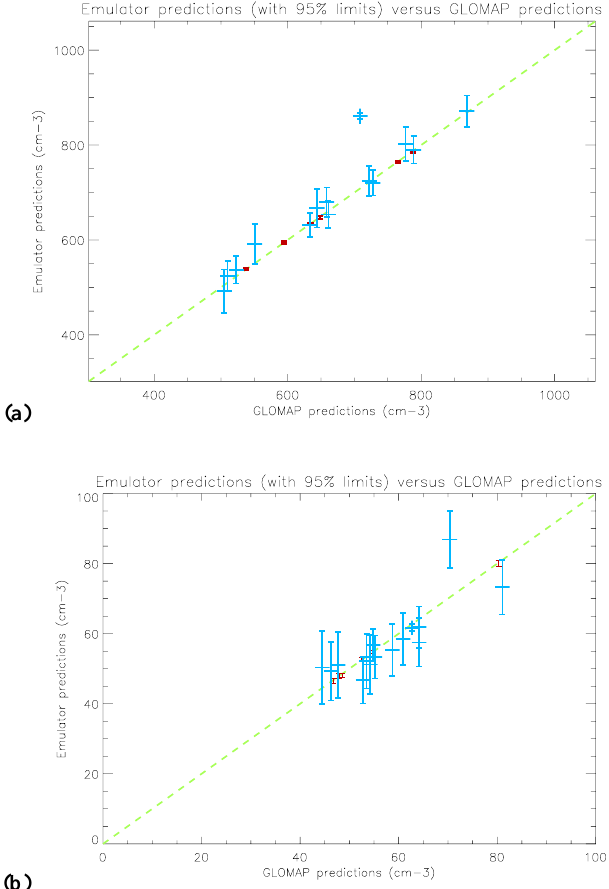
Fig. 5. GLOMAP estimates of June 2000 surface CCN concentra- tions in (a) London and (b) the Pacific Ocean versus emulator pre- dictions of June 2000 surface CCN with 95% probability (2 σ ) lim- its. The uncertainty here represents the emulator uncertainty rather than uncertainty due to the parameters. The red points are those from the experimental design that were purposely placed close to the original training